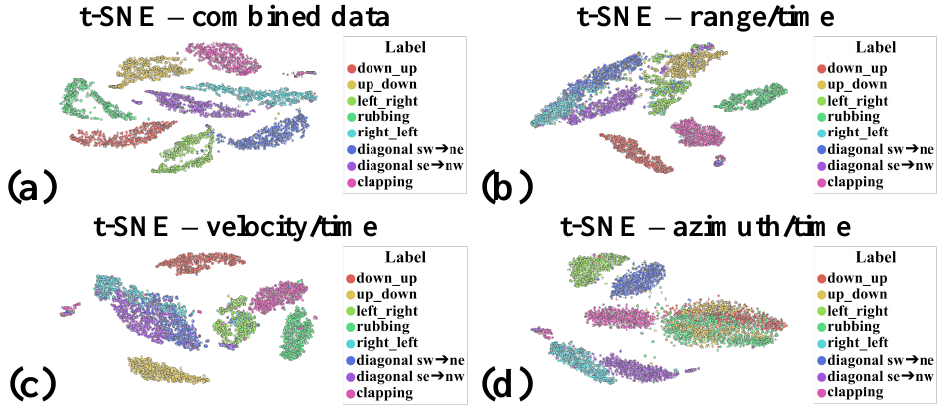
Figure 7. ( a ) t-SNE representation of all information, including range time maps, velocity time maps, and azimuth time maps. It is clearly visible that the composition of this information together allows for the separation of clusters; ( b ) t-SNE representation of range time maps; ( c ) t-SNE representation of velocity time maps; and ( d ) t-SNE representation of azimuth time